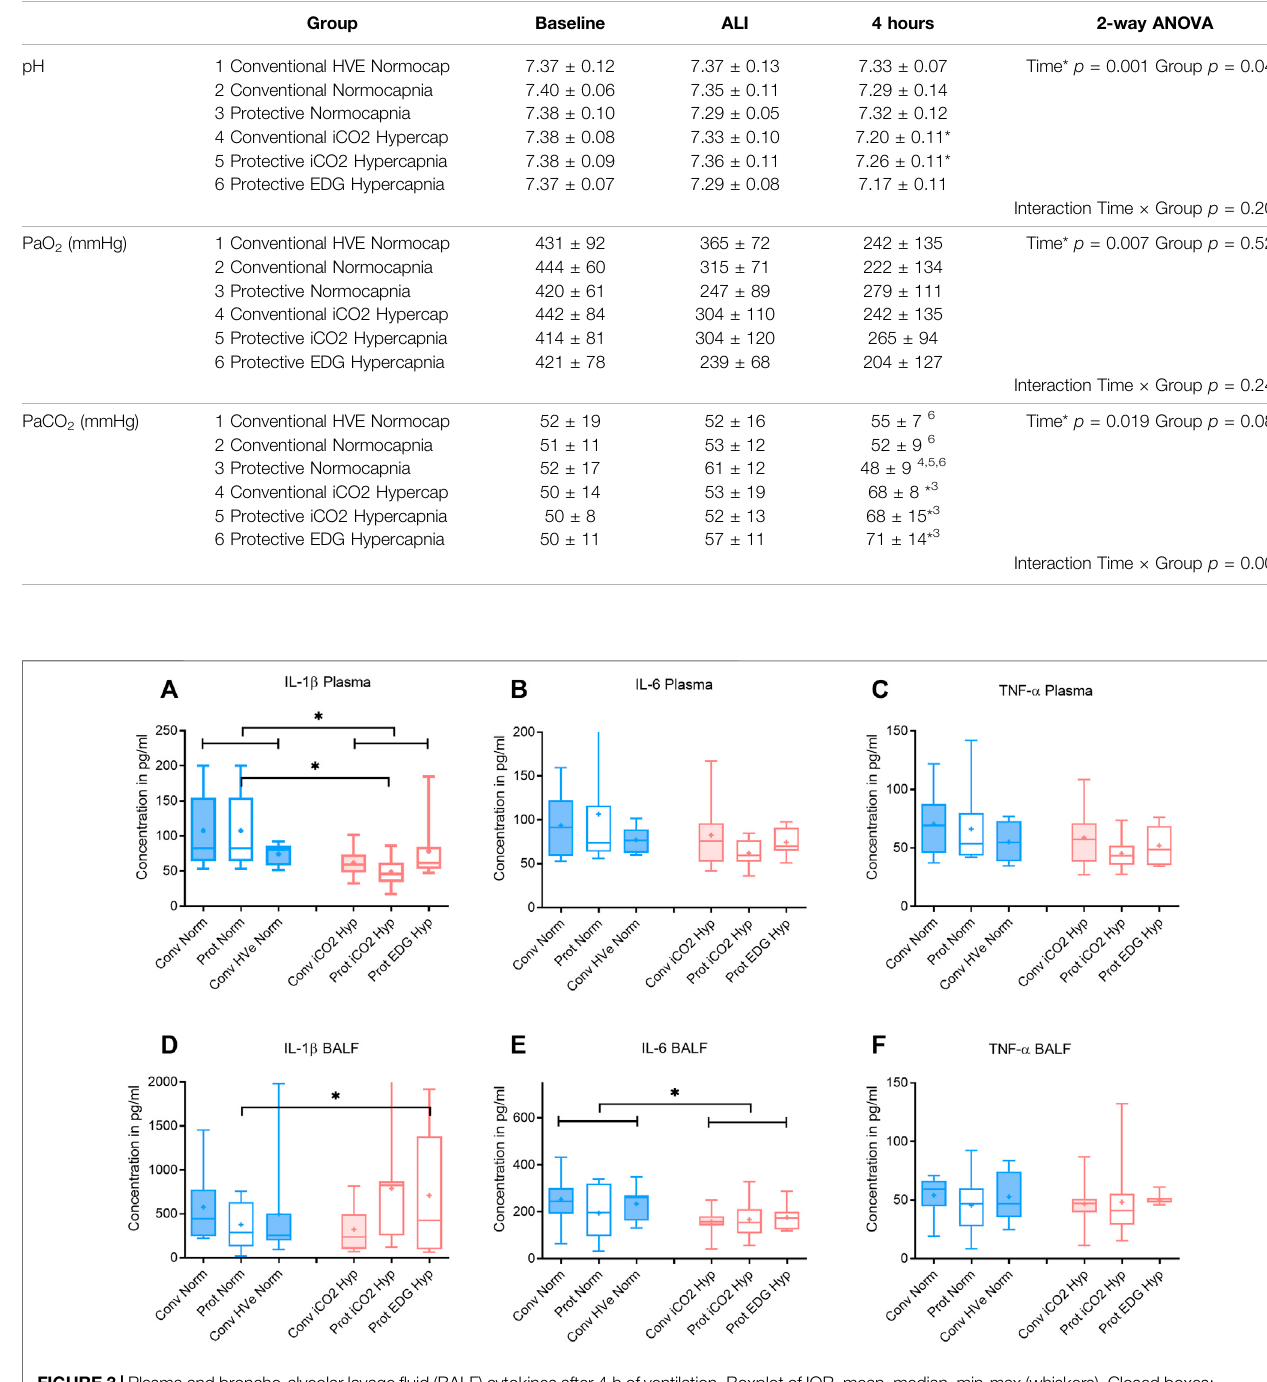
FIGURE 3 | Plasma and broncho-alveolar lavage fl uid (BALF) cytokines after 4 h of ventilation. Boxplot of IQR, mean, median, min-max (whiskers). Closed boxes: high tidal volumes; open boxes: low tidal volumes; blue color: normocapnia; red color: hypercapnia. * denotes signi fi cant differences between groups.